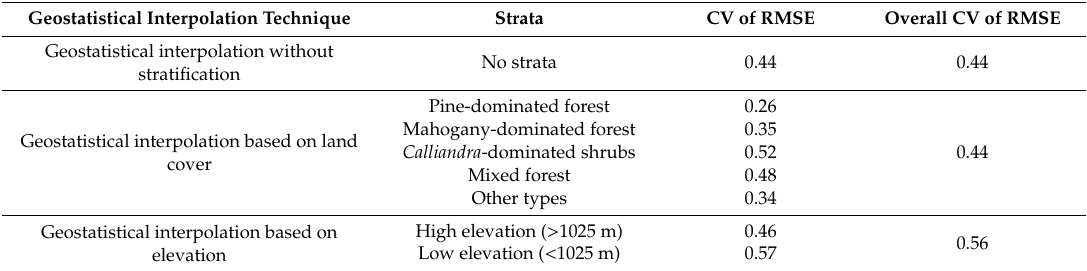
Table 5. Coe ffi cients of variation (CVs) of the root mean square error (RMSE) of the geostatistical interpolation of aboveground carbon in the Geulis Mountain